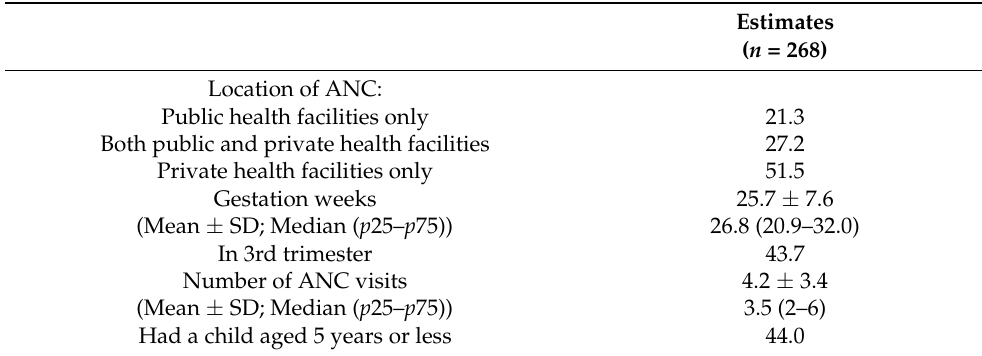
Table 3. Proportion of respondents with children under 5 years, frequency and location of antenatal care, and gestational age 1 .